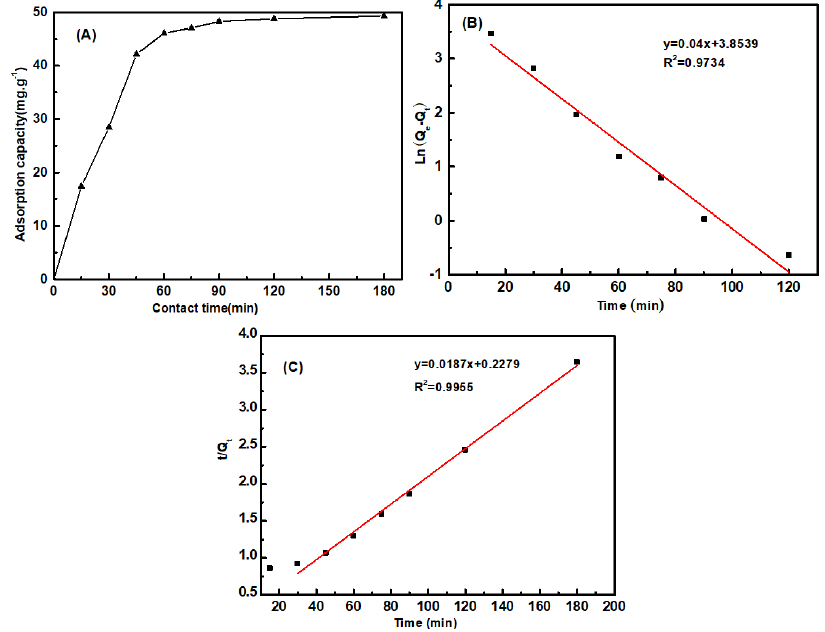
Figure 12. The effect of contact time on adsorption capacity ( A ) and the linearized pseudo-first-order ( B ) and pseudo-second-order ( C ) kinetics. ( B ) and pseudo-second-order ( C )